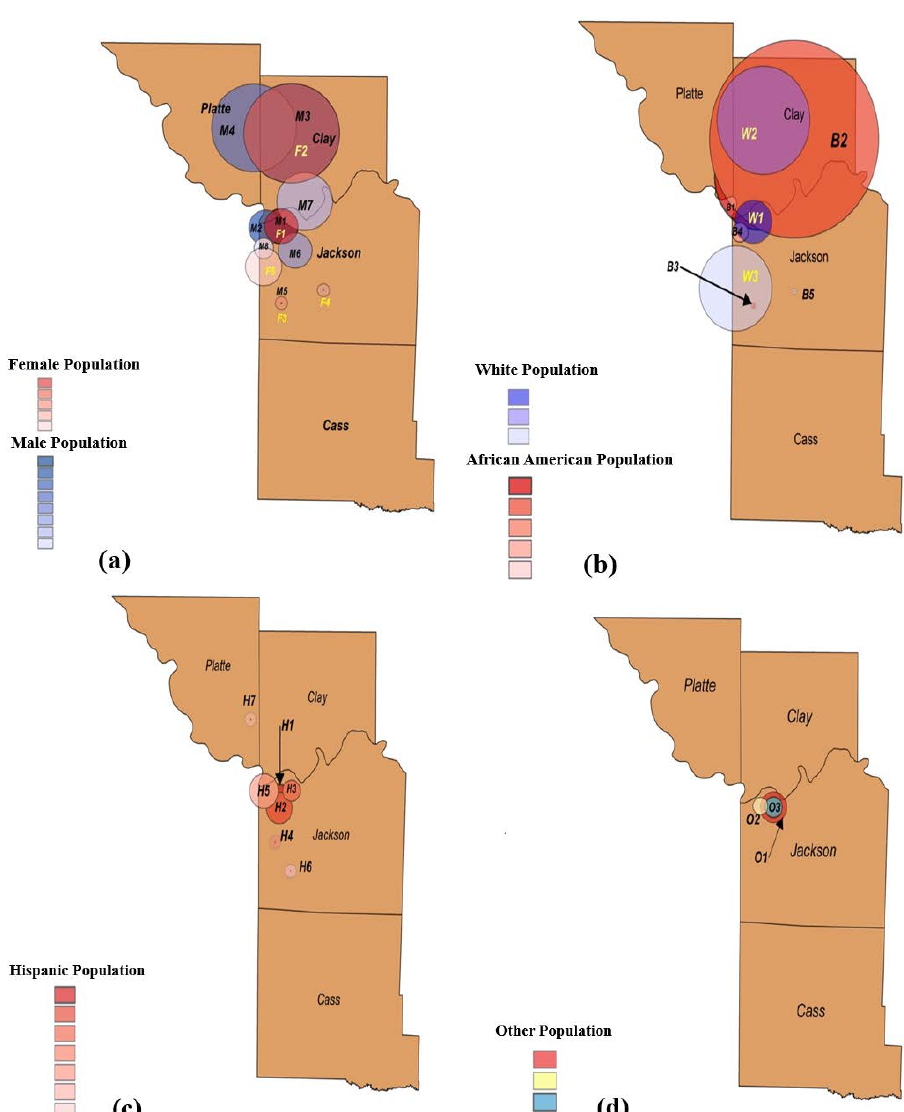
Table 6. Spatial clusters of COVID-19 with respect to Hispanic (H) and Other (O) populations (i.e., Asian, American In- dian, and Hawaiian and Pacific Islander).